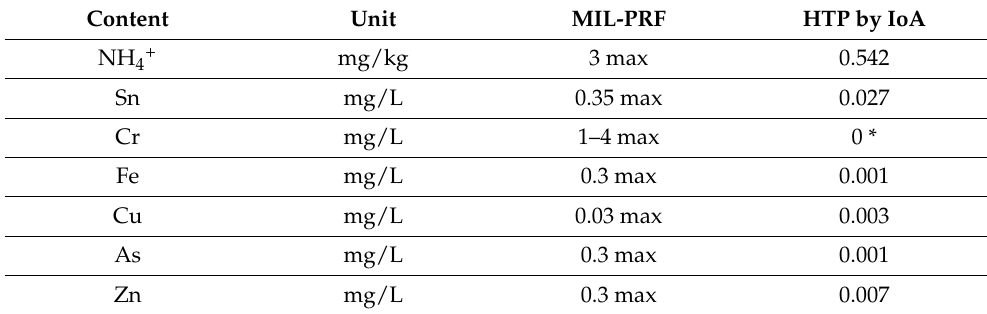
Table 1. Quality data of HTP prepared by IoA on the background of MIL-PRF16005F standard.